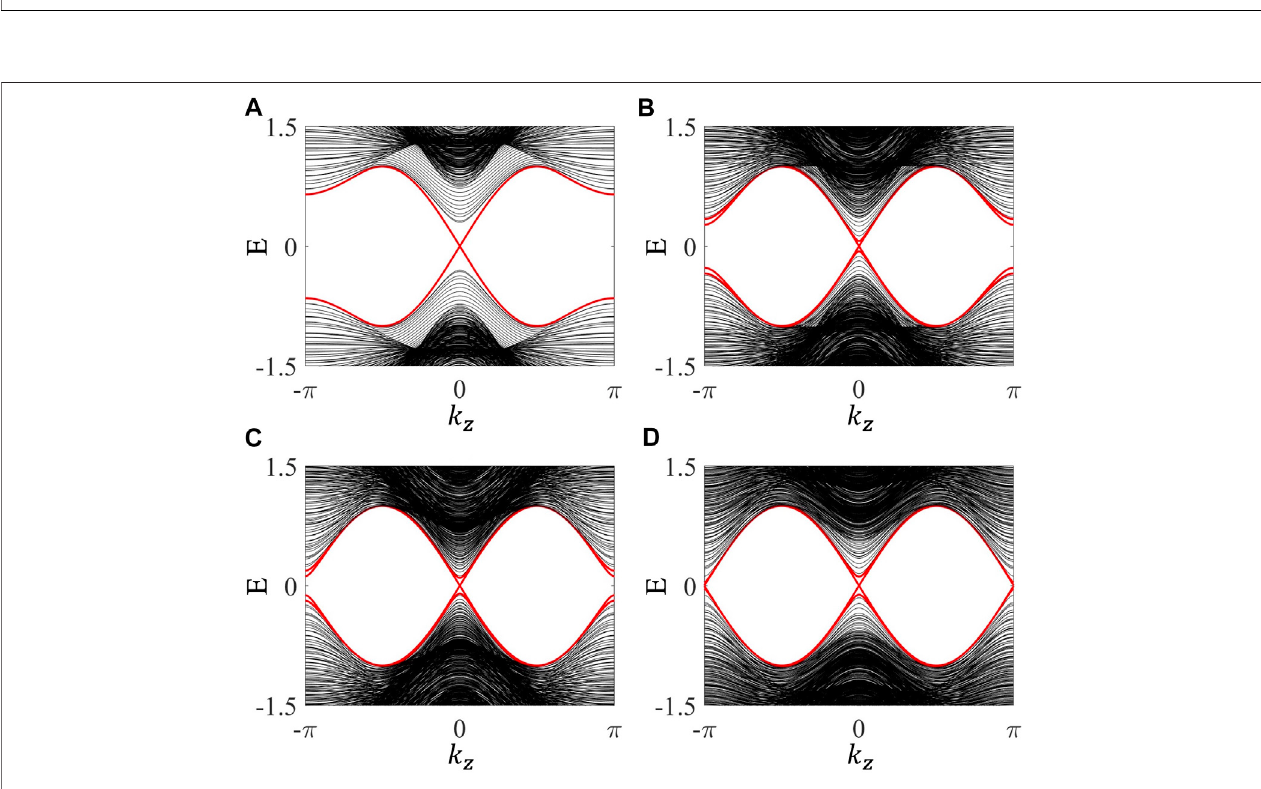
FIGURE 9 | (Color online) The evolution of gapless hinge states with respect to Zeeman fi eld. Chosen parameters are: t = 1, m = 1.6, λ = 1, η = 0.2. In (A – D) , all energyspectraareforageometrywithperiodicboundaryconditiononlyinthe z direction.Thesystemsizeinthe x and y directionsis fi xedto N x = N y =20. (A) t z =1, B x = B y = 0, the four-fold degeneracy of the crossing red lines reveals that each z -direction hinge harbors a pair of helical states. (B) t z = 1, B x = B y = 0.28, the surface energy gap vanishes at this critical value. (C) t z = 1, B x = B y = 0.4, the degeneracy of the crossing red lines is reduced by half, corresponding to the transition from helical hinge states to chiral hinge states. (D) t z = 0.5, B x = B y = 0.25, chiral hinge states remain even though the energy spectrum at the k z = π plane becomes